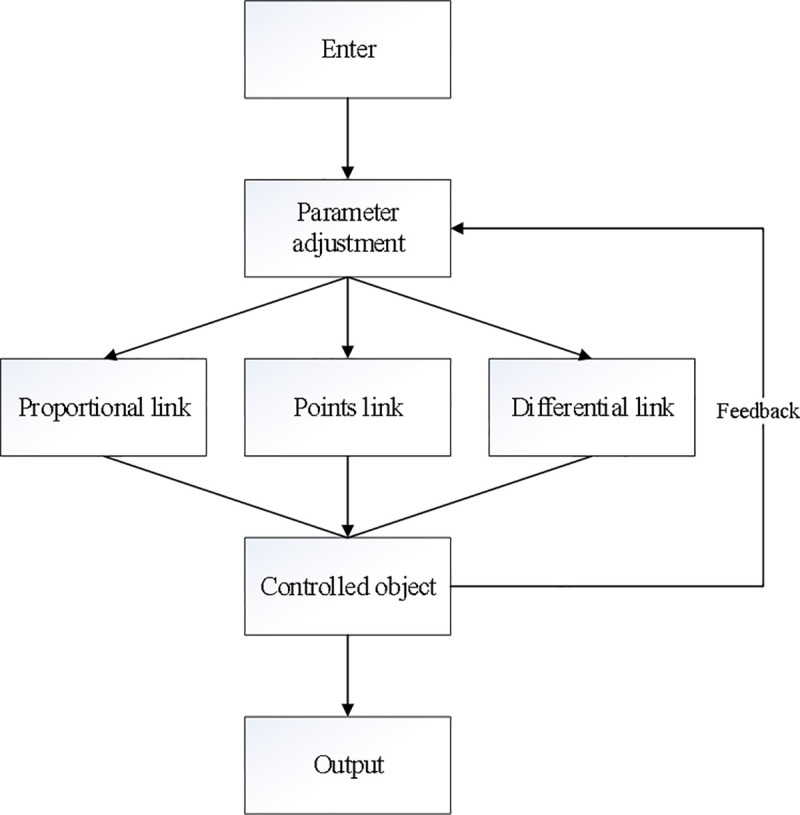
The control process of traditional PID controller.